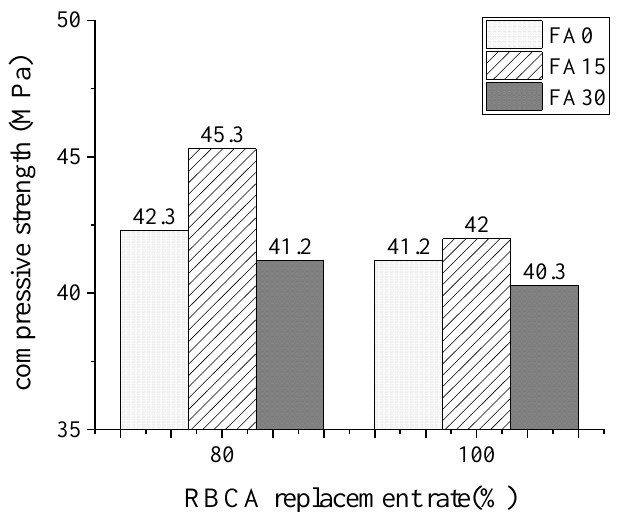
Figure 5. Twenty-eight-day compressive strength of concrete with different recycled aggregate content.